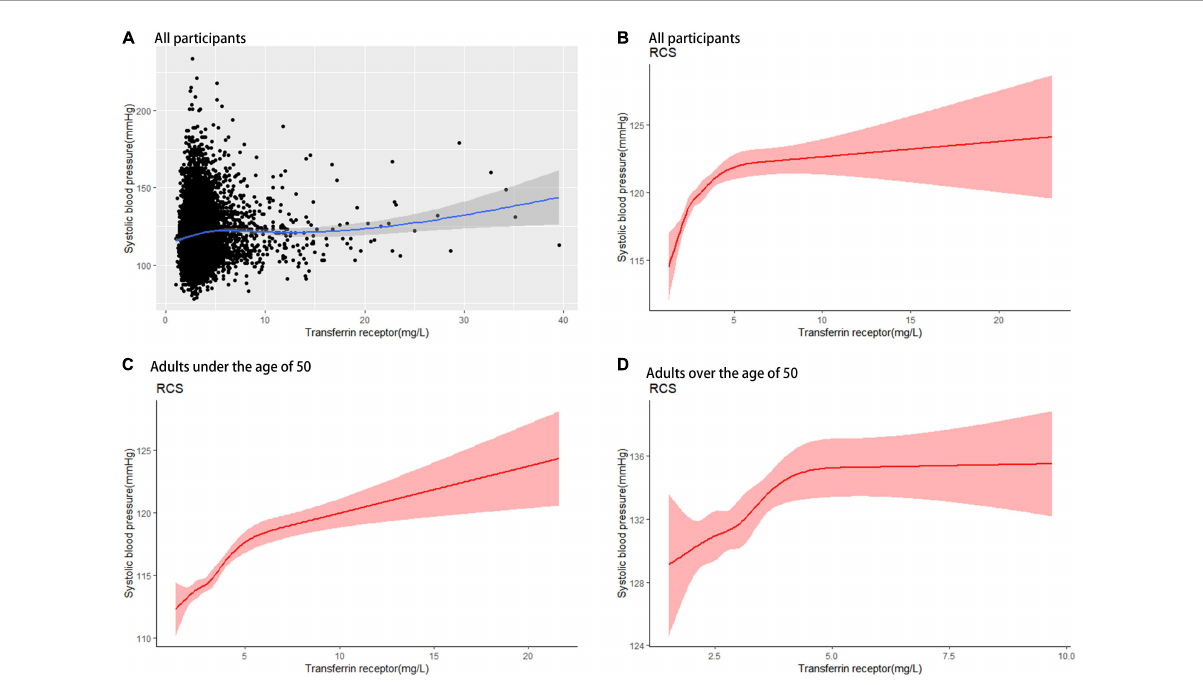
FIGURE2 RCS of sTfR with systolic blood pressure. (A) sTfR concentrations with systolic blood pressure in all participants. (B) sTfR restricted cubic spline regression with 5 knots in all participants; shaded areas inside the dashed lines are 95% CIs. (C) sTfR restricted cubic spline regression with 5 knots in adults under the age of 50; shaded areas inside the dashed lines are 95% CIs. (D) sTfR restricted cubic spline regression with 5 knots in adults over the age of 50; shaded areas inside the dashed lines are 95% CIs. sTfR, soluble transferrin receptor; RCS, restricted cubic